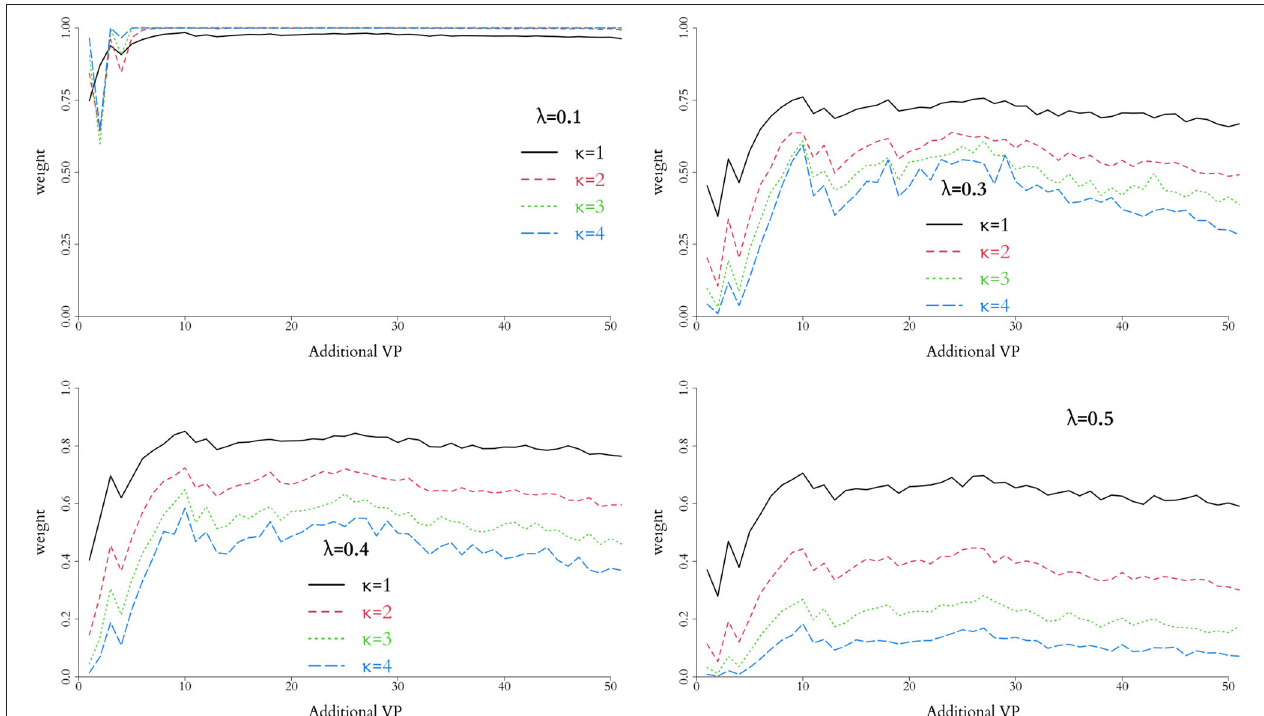
FIGURE 5 | Weight associated with each combination of parameters in the weight function, h ( p ), for the RUTI group. Relative low values of λ do not provide clear separation, regardless of the potential number of additional virtual patients. For the data observed, λ = 0.4 and κ = 1 provide appropriate separation and suggest adding 12–30 virtual patients to the combined